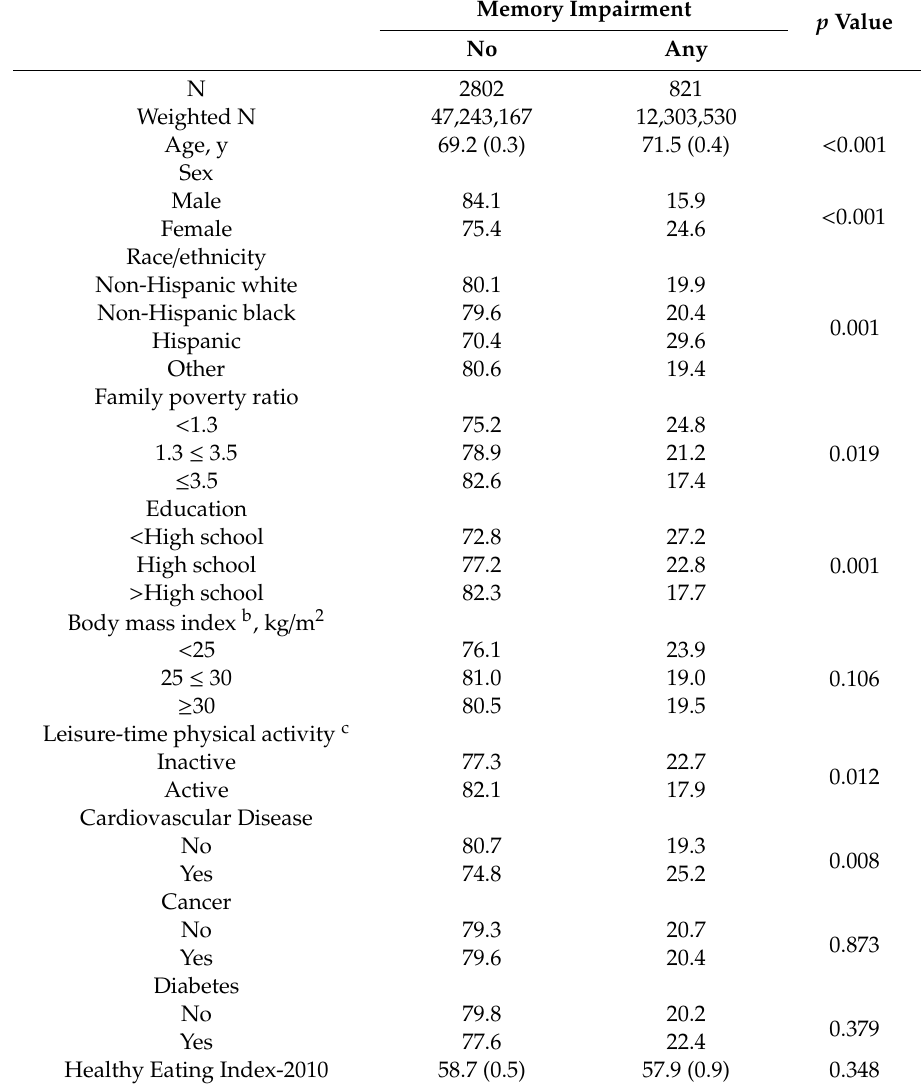
Table 2. Characteristics of the US Adults ≥ 60 years According to Memory Impairment, NHANES 2011–2014 a